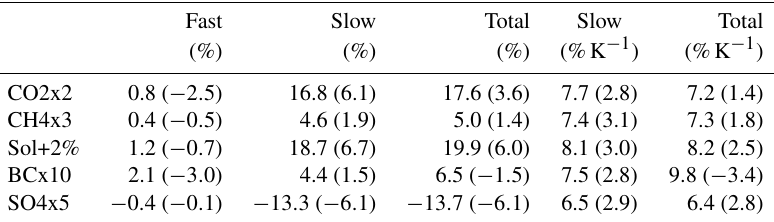
Table 1. Global- and annual-mean relative changes in integrated water vapour and with evaporation/precipitation in parentheses (note that global-mean evaporation and precipitation are equal) for five different drivers, and split into fast, slow and total responses, using the mean of PDRMIP results. In the two rightmost columns, values have been divided by the global- and annual-mean (cid:49)T s induced by each driver. Fast